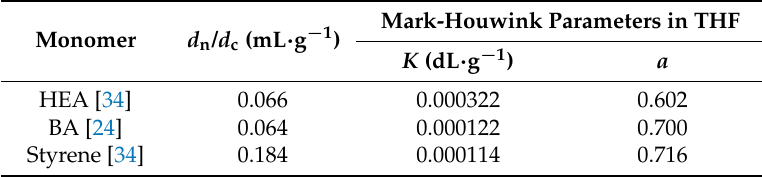
Table 1. Parameters required for analysis of polymer molar mass averages and